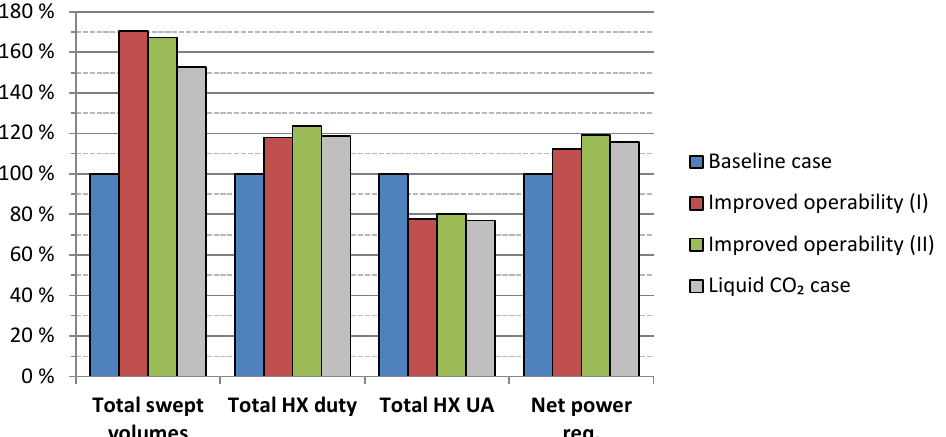
Figure 16. Comparison of relative values for the four different cases. Base case is defined as reference point (100%) for all categories.